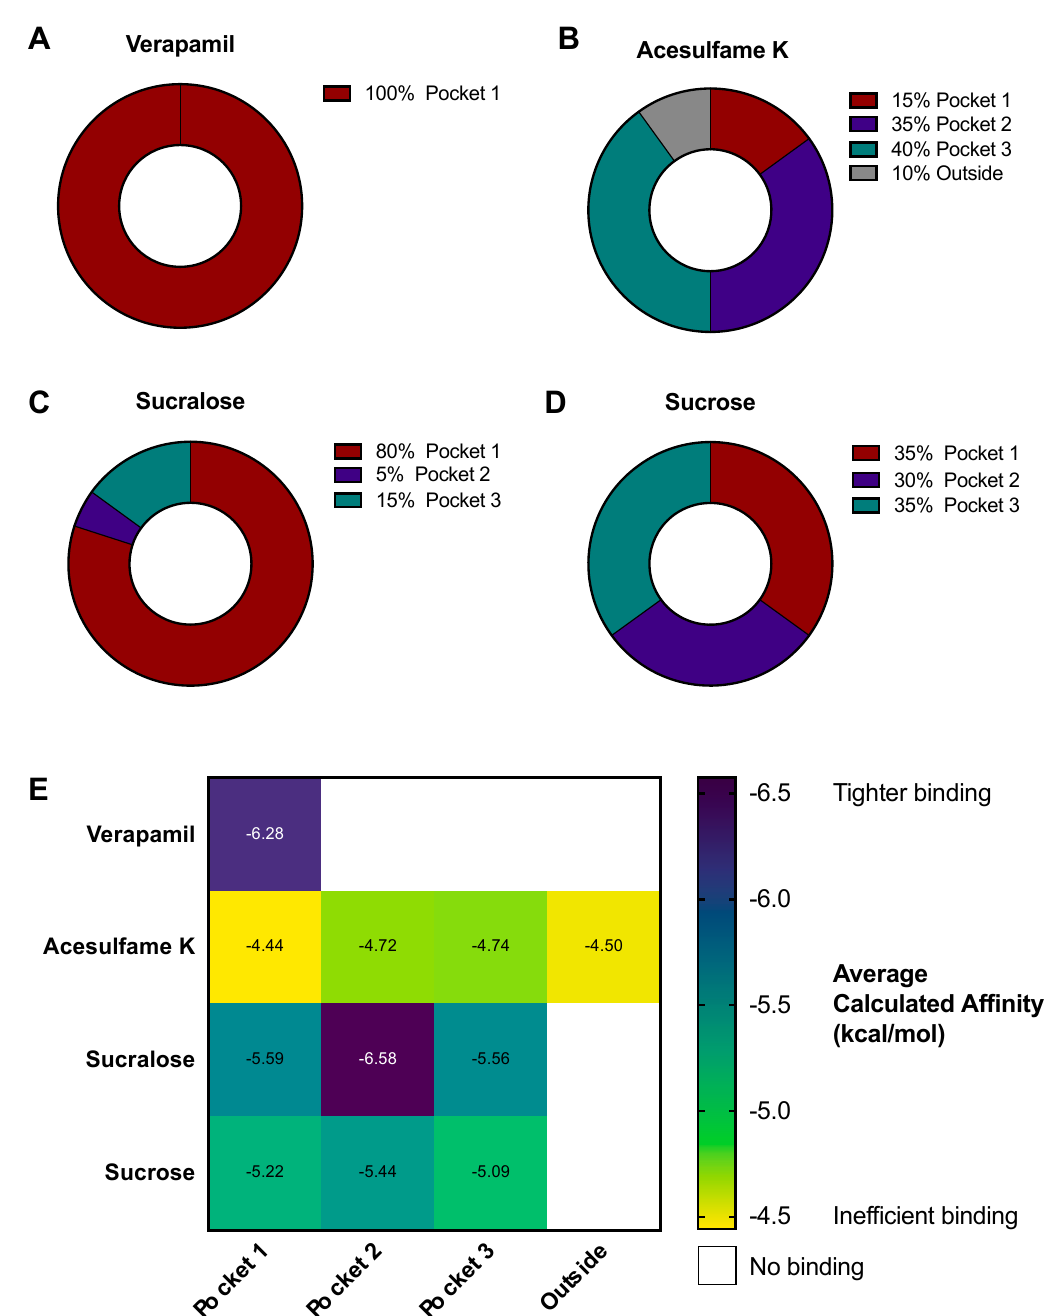
Figure 5. Binding pocket occupancy for compounds docked on PGP. All docking poses for each compound were visualized on PyMOL and inventoried according to their position in PGP transmembrane binding pockets. ( A – D ) Frequency of poses in each binding pocket for each docked compound. ( E ) Average calculated binding affinity for each compound and binding pocket combination. Tighter binding indicated by indigo and weaker, inefficient binding indicated in yellow. Compound/binding pocket combinations that were not found among top 20 docking poses are shown in white.